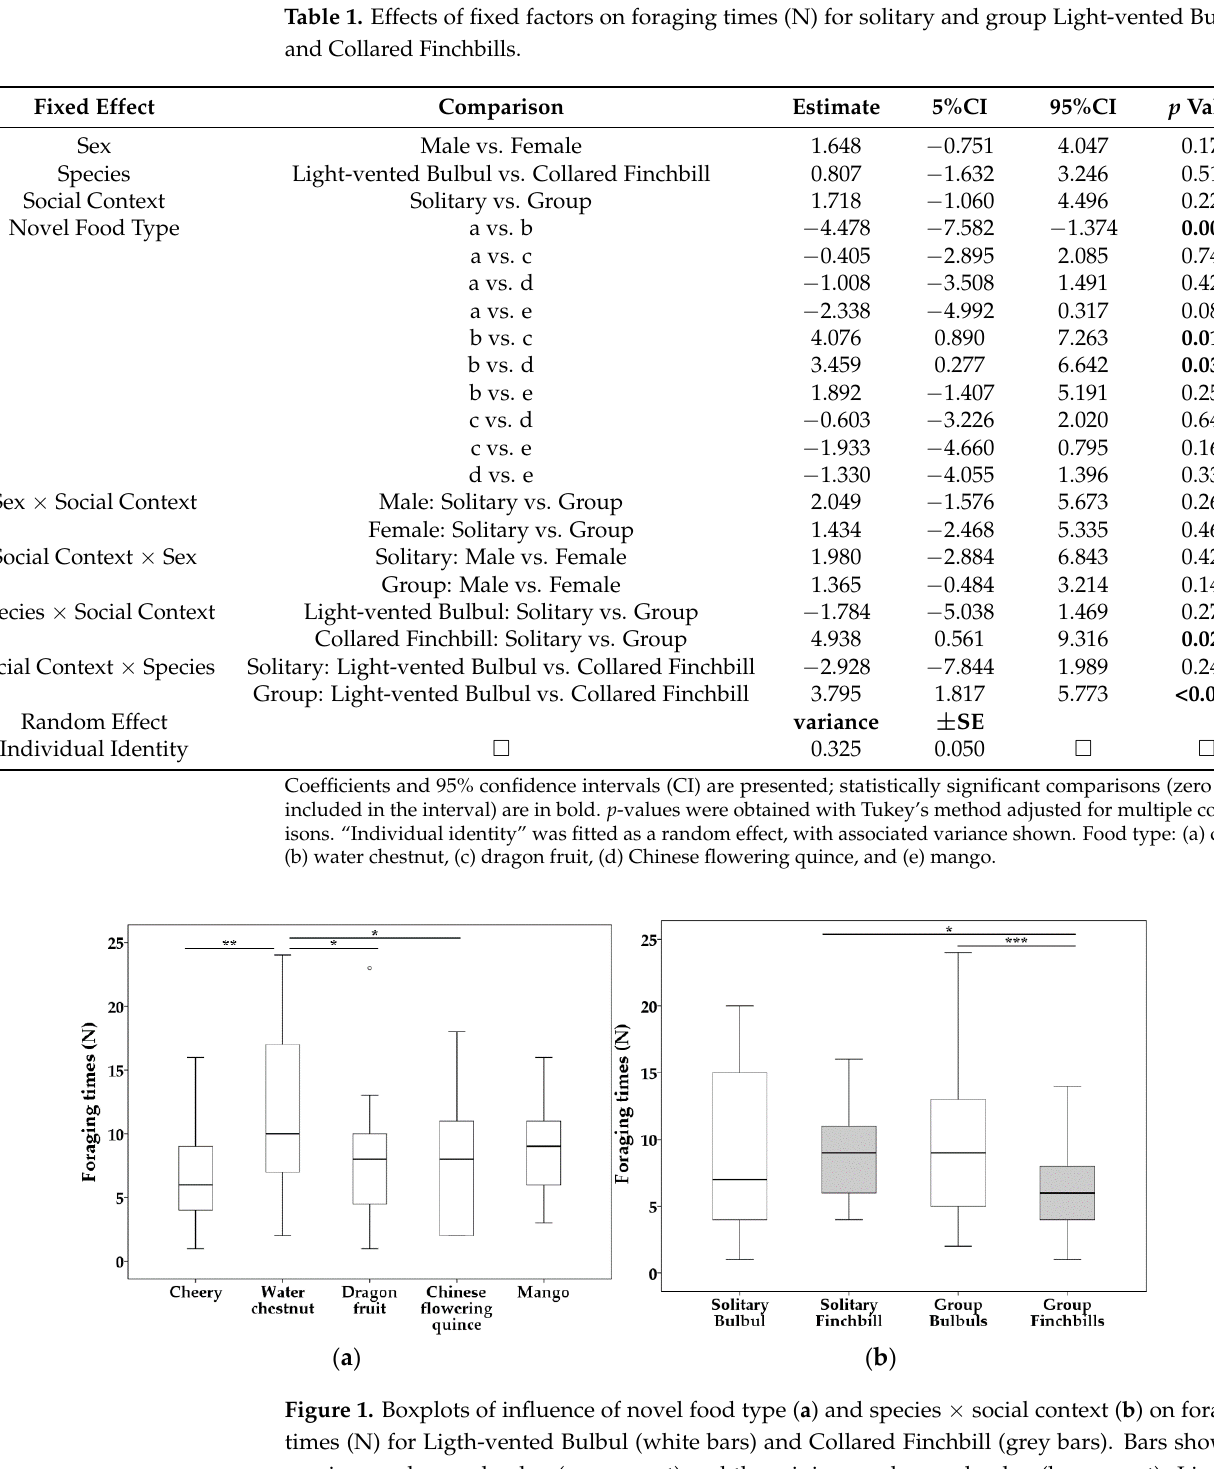
Table 1. Effects of fixed factors on foraging times (N) for solitary and group Light-vented Bulbuls and Collared Finchbills.